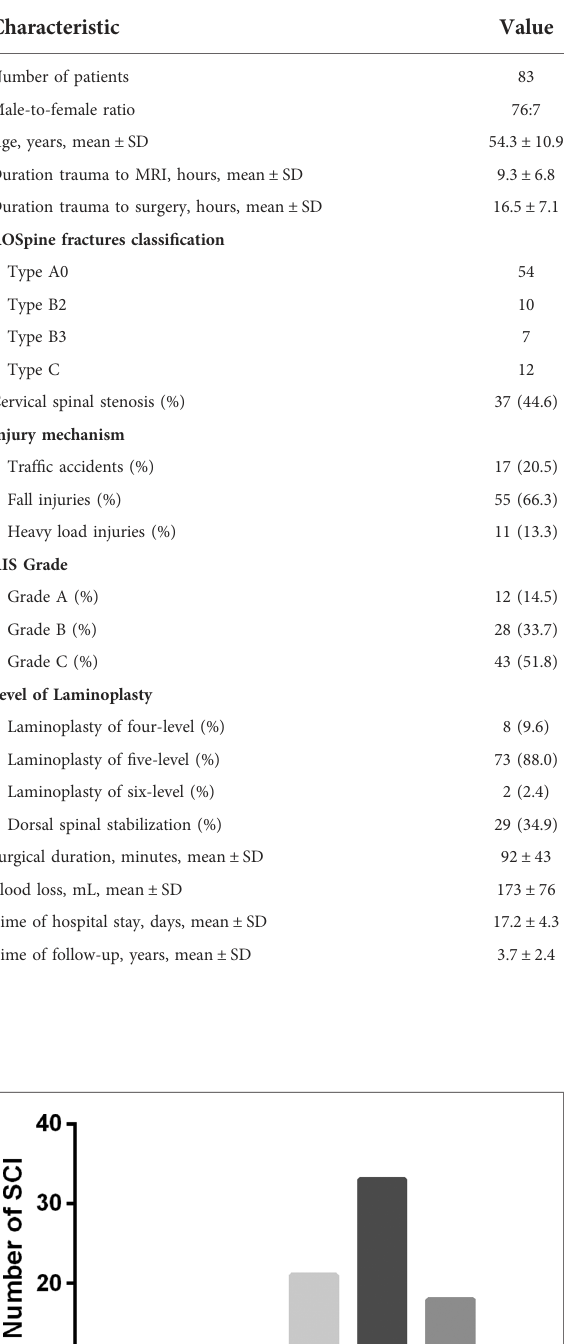
TABLE 2 Mean intramedullary lesion length and hematoma length.